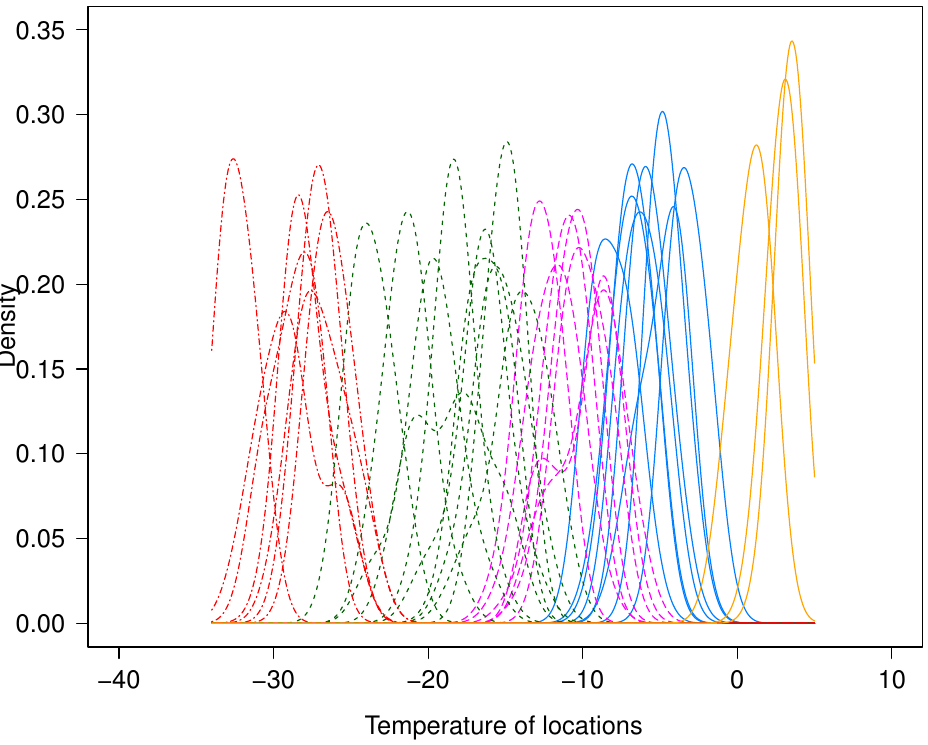
Figure A2. Densities of the Canadian weather stations by cluster. From left to right, C1: red densities, C2: green densities, C4: purple densities, C3: blue densities, and C5: orange densities. Table A1. Clusters resulting from data of Canadian weather stations. Cluster